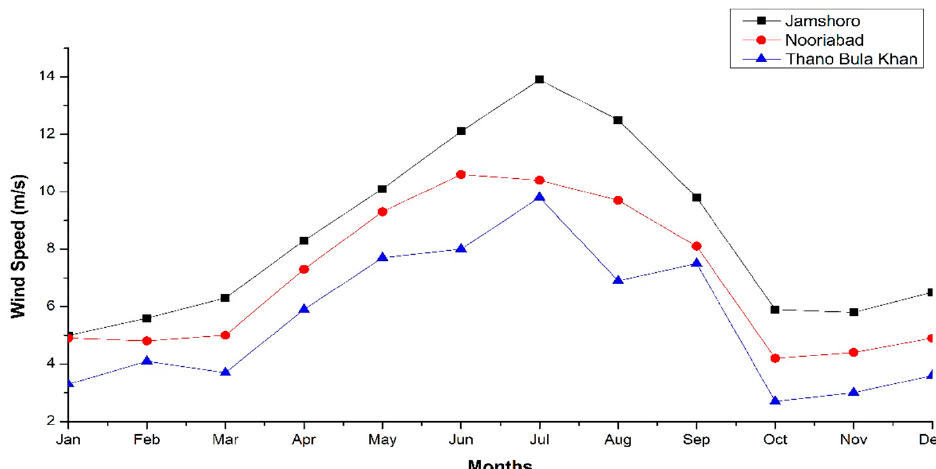
Figure 15 . Annual Wind Speed for Zone 4 (Jamshoro).